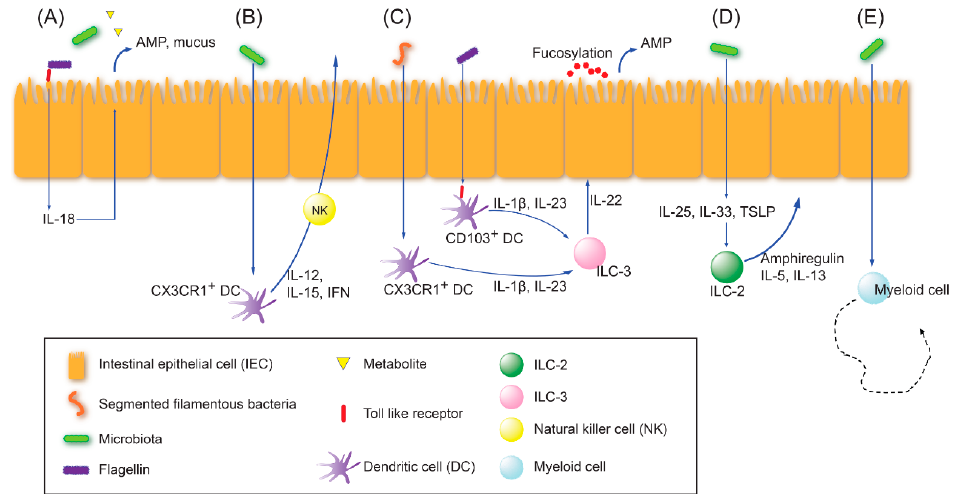
Figure 1. The major interplay pathways between gut microbiota and innate immune cells. ( A ) Epithelial interleukin (IL)-18 orchestrates to produce antimicrobial peptide and mucus. ( B ) CX 3 CR1 + dendritic cells prime natural killer (NK) cells fighting against enteric pathogens. ( C ) Group 3 innate lymphoid cells (ILC3s) produce IL-22 mediated by IL-1 β and IL-23 from CD103 + or CX 3 CR1 + dendritic cells after sensing flagellin or segmented filamentous bacteria. IL-22 modulates epithelial cells to produce antimicrobial peptides and to stimulate surface fucosylation. ( D ) ILC2s produce IL-5, IL13, and amphiregulin to promote the growth of epithelial cells. ( E ) The microbiota affects the myelopoiesis in bone marrow, and the migration and phenotypes of circulating or tissue-resident myeloid cells. (Modified from the study by Thaiss et al.